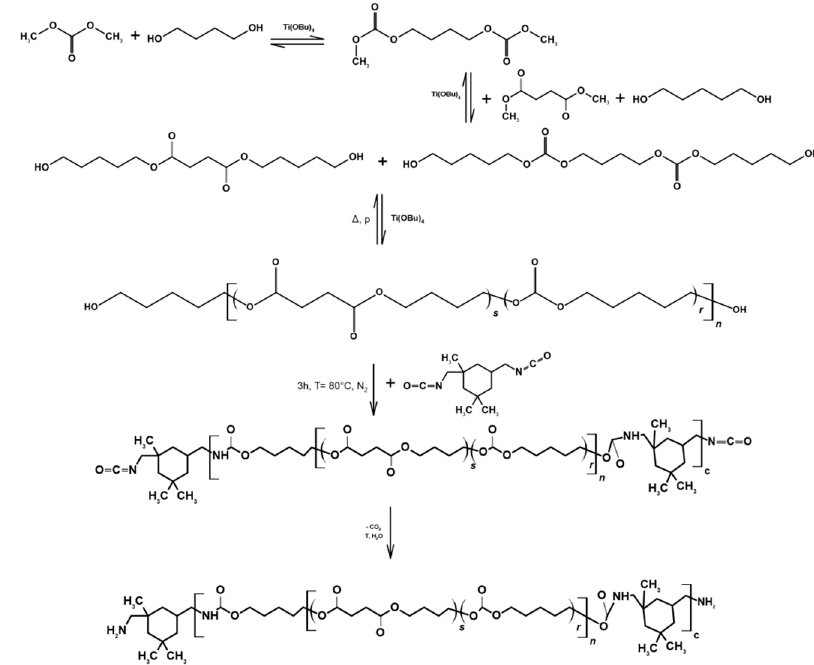
Figure 1. The scheme of the PUR synthesis.